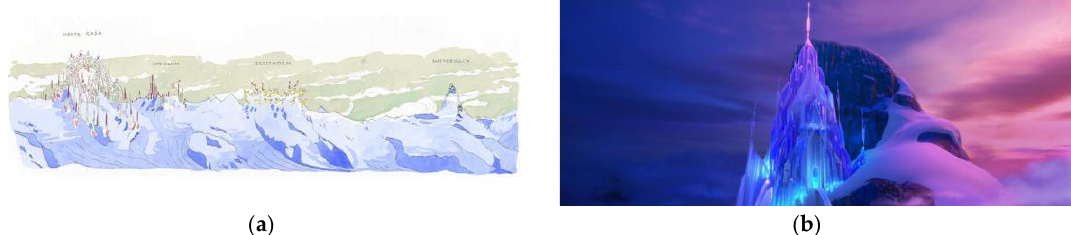
Figure 6. Example of permanence of utopic images of construction in the high mountains: ( a ) drawing by Bruno Taut, 1919; ( b ) frame from the animation movie Frozen (Walt Dysney Animation Studios, 2013).